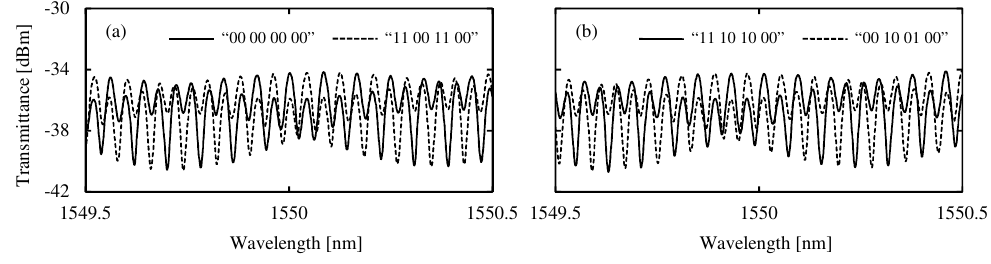
Figure 4. Transmission spectra of the 8-bit optical comparator: ( a ) “00 00 00 00” and “11 00 11